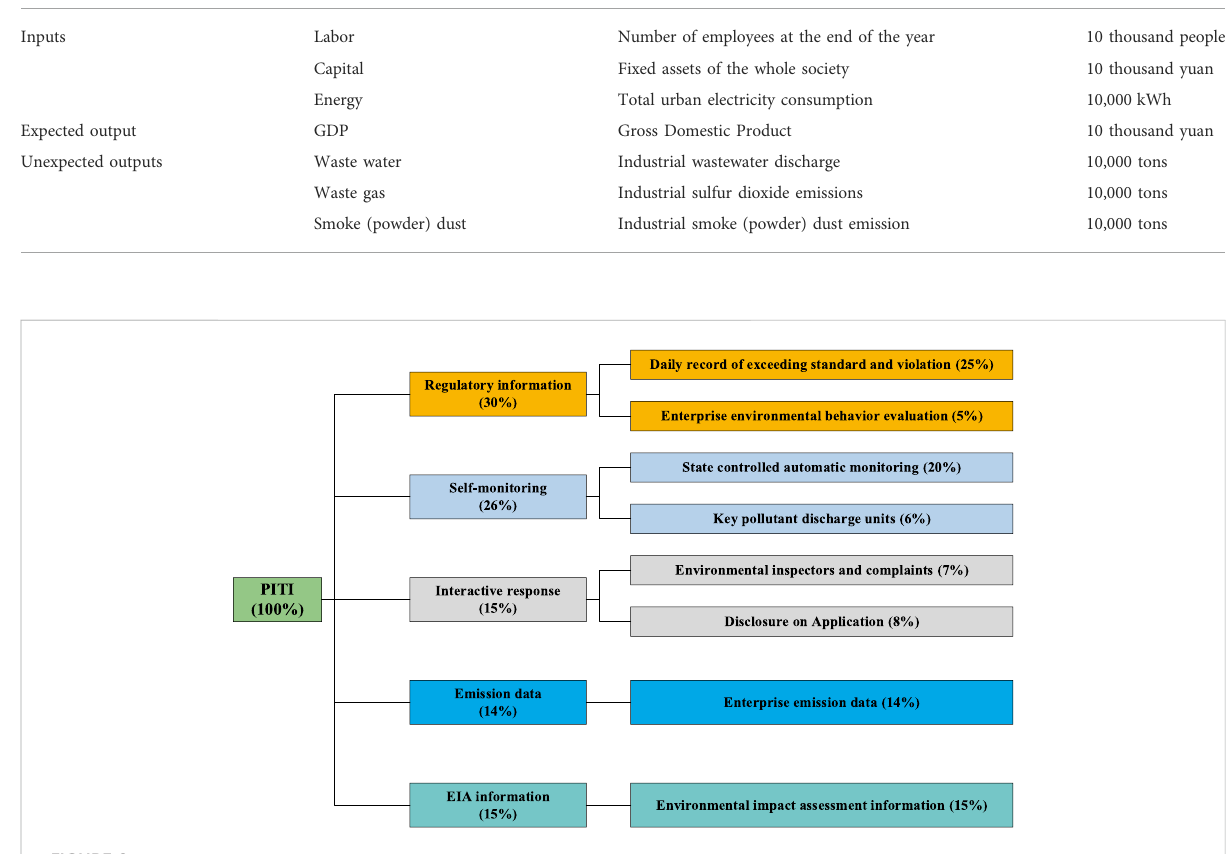
FIGURE 2 Evaluation system and weight of